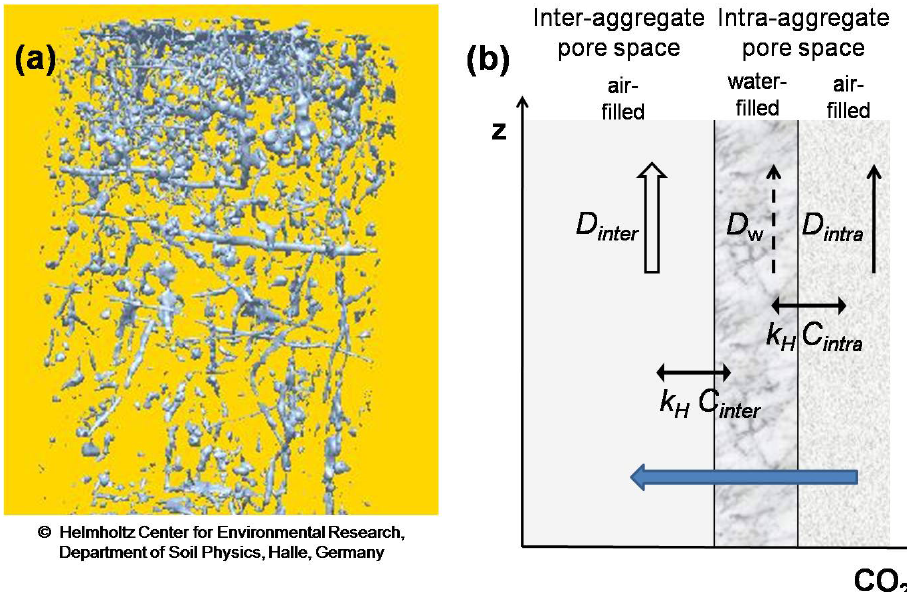
Fig. 6. (a) X-ray computed tomography scan of the inter-aggregate pores > 2mm (blue) in a Terra fusca soil. The image covers a depth of ∼ 0.25m. (b) Conceptual graph illustrating the CO 2 exchange at the interfaces between air- and water-filled pores. For simplicity, an equilibration according to Henry’s law is assumed ( C =CO 2 concentration, k H =Henry’s law constant). The different upward arrows illustrate that the diffusion coefficients D are larger in air-filled inter-aggregate ( D inter ) than intra-aggregate pores ( D intra ) , and smallest in water-filled pores ( D w ) . This results in a CO 2 gradient and hence a net exchange flux which persists during steady state (blue